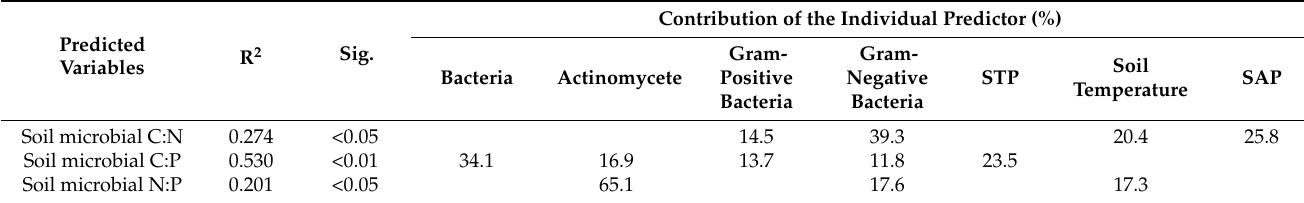
Bacteria Actinomycete